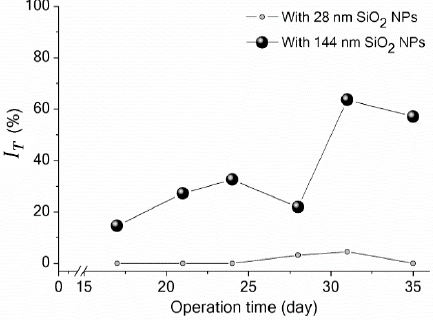
Figure 5. Inhibition of activated sludge total respiration ( (cid:1835) (cid:3021) ) in an MBR by SiO 2 NPs. The lesser inhibitory effect of 28 nm SiO 2 NPs compared with that of 144 nm SiO 2 NPs may be